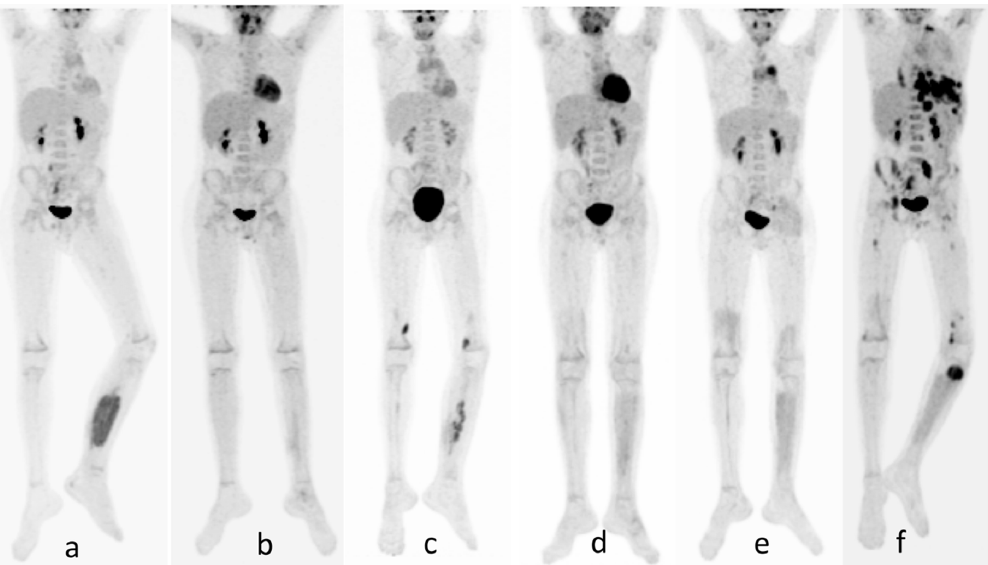
Figure 1. Patient 1. A 9-year-old boy with alveolar rhabdomyosarcoma [1–7] of the extremities (left popliteal region) was diagnosed by MRI and by biopsy (negative sentinel inguinal lymph node), and a staging 18F-FDG PET-CT [8,9] was performed. The whole-body PET-CT exam ( a ) showed a pathologic uptake (SUVmax 5.1 with Lesion SUVmax/Liver SUVmax Tumor Liver Ratio (TLR) <4.6) at the middle third of the left leg in the deep posterior compartment, involving the long flexor muscle of the fingers and the long flexor muscle of the big toe (PET-CT and MRI fusion imaging) and absence of other foci of pathological uptake in the remaining explored field of view. Brain MRI was negative for secondary lesions. Chemotherapy, according to EpSSg RMS 2005 protocol High-risk group G, was performed and for local control, photon radiotherapy (50.4 Gy in 28 fractions in the left calf). There was no surgery because it was complete remission at the control after the third cycle of chemotherapy.